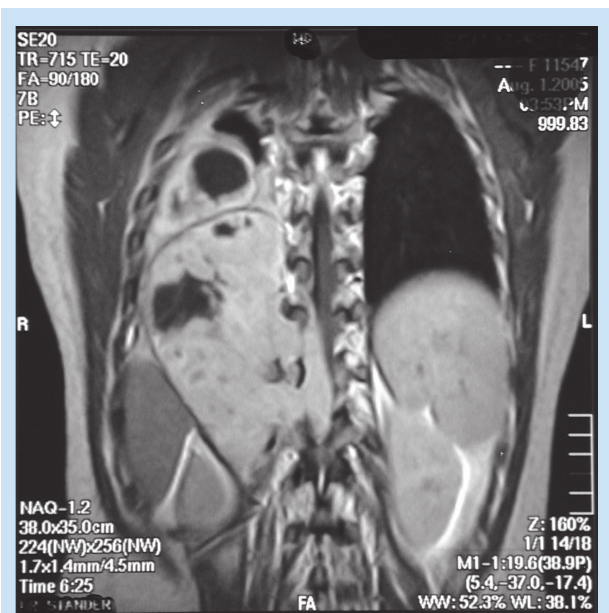
Fig. 5. A coronal post-contrast T1-weighted sequence. The mass enters the spinal canal via numerous neural